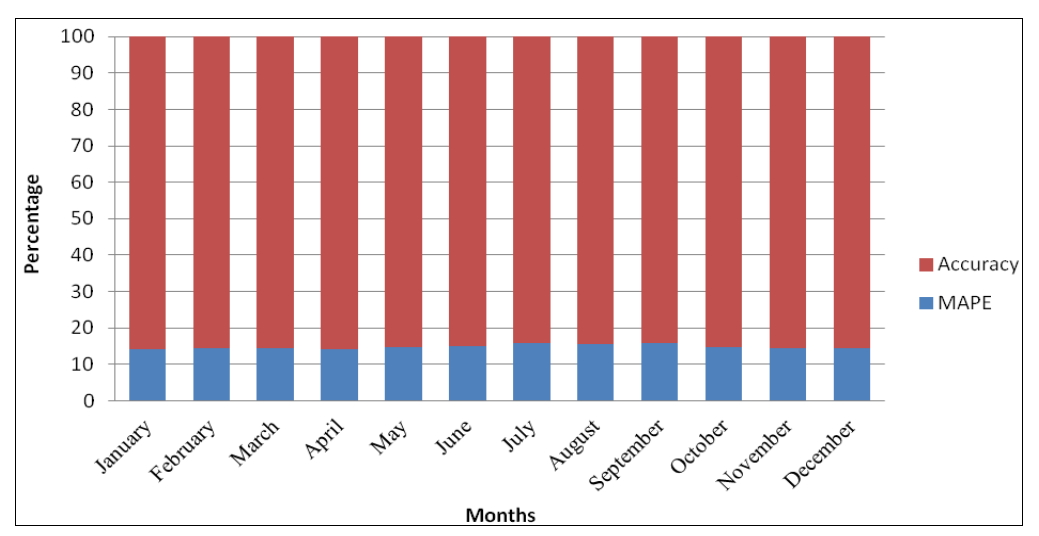
Figure 5. Cross-validation for accuracy of Bayesian kriging for predictive distribution of HPAI H5N1 in the Red River